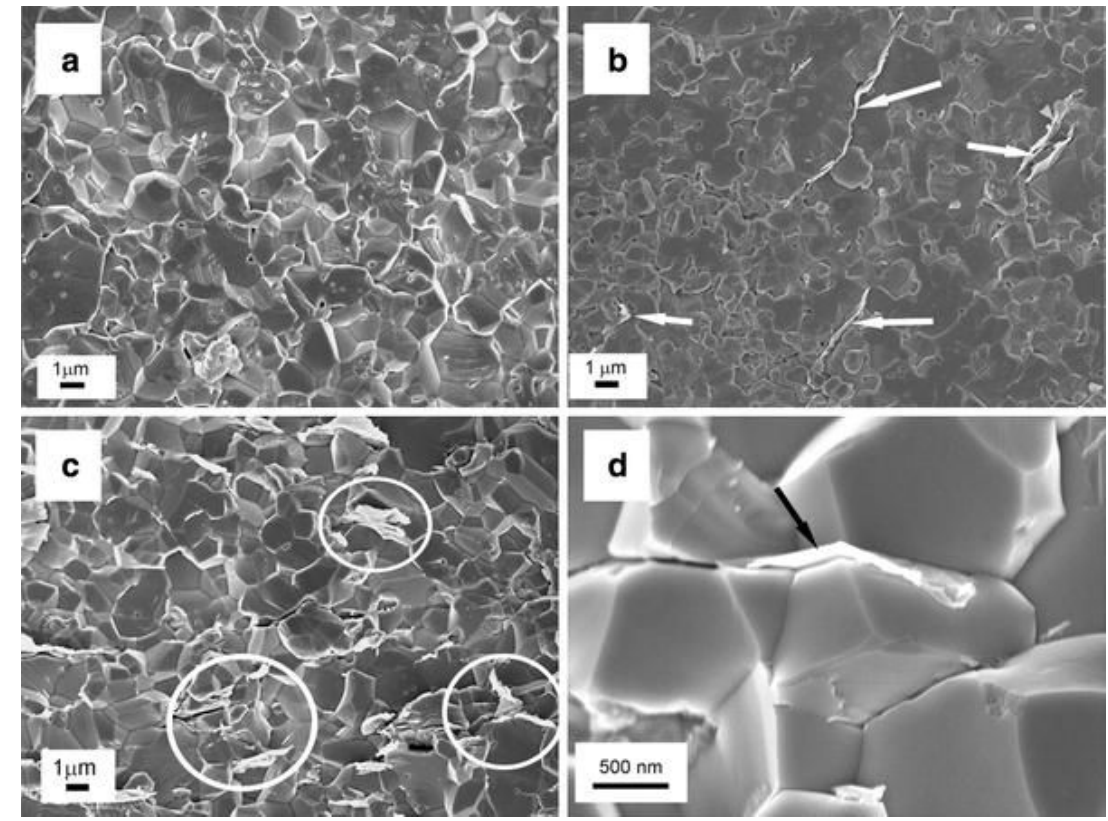
Figure 5: (a) Al 2 O 3 ; (b) Al 2 O 3 -0.75 wt% GNP; (c) GNP winding around Al 2 O 3 grains